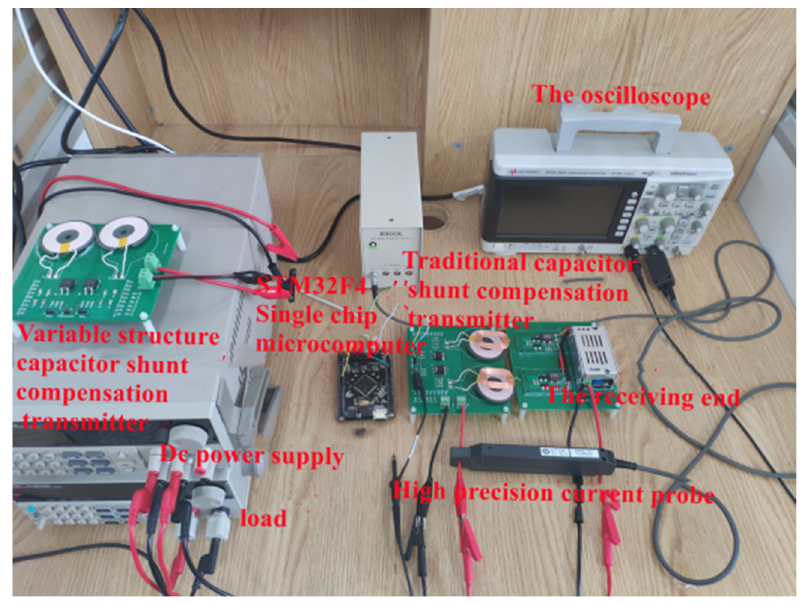
Figure 20. Physical diagram of hardware .